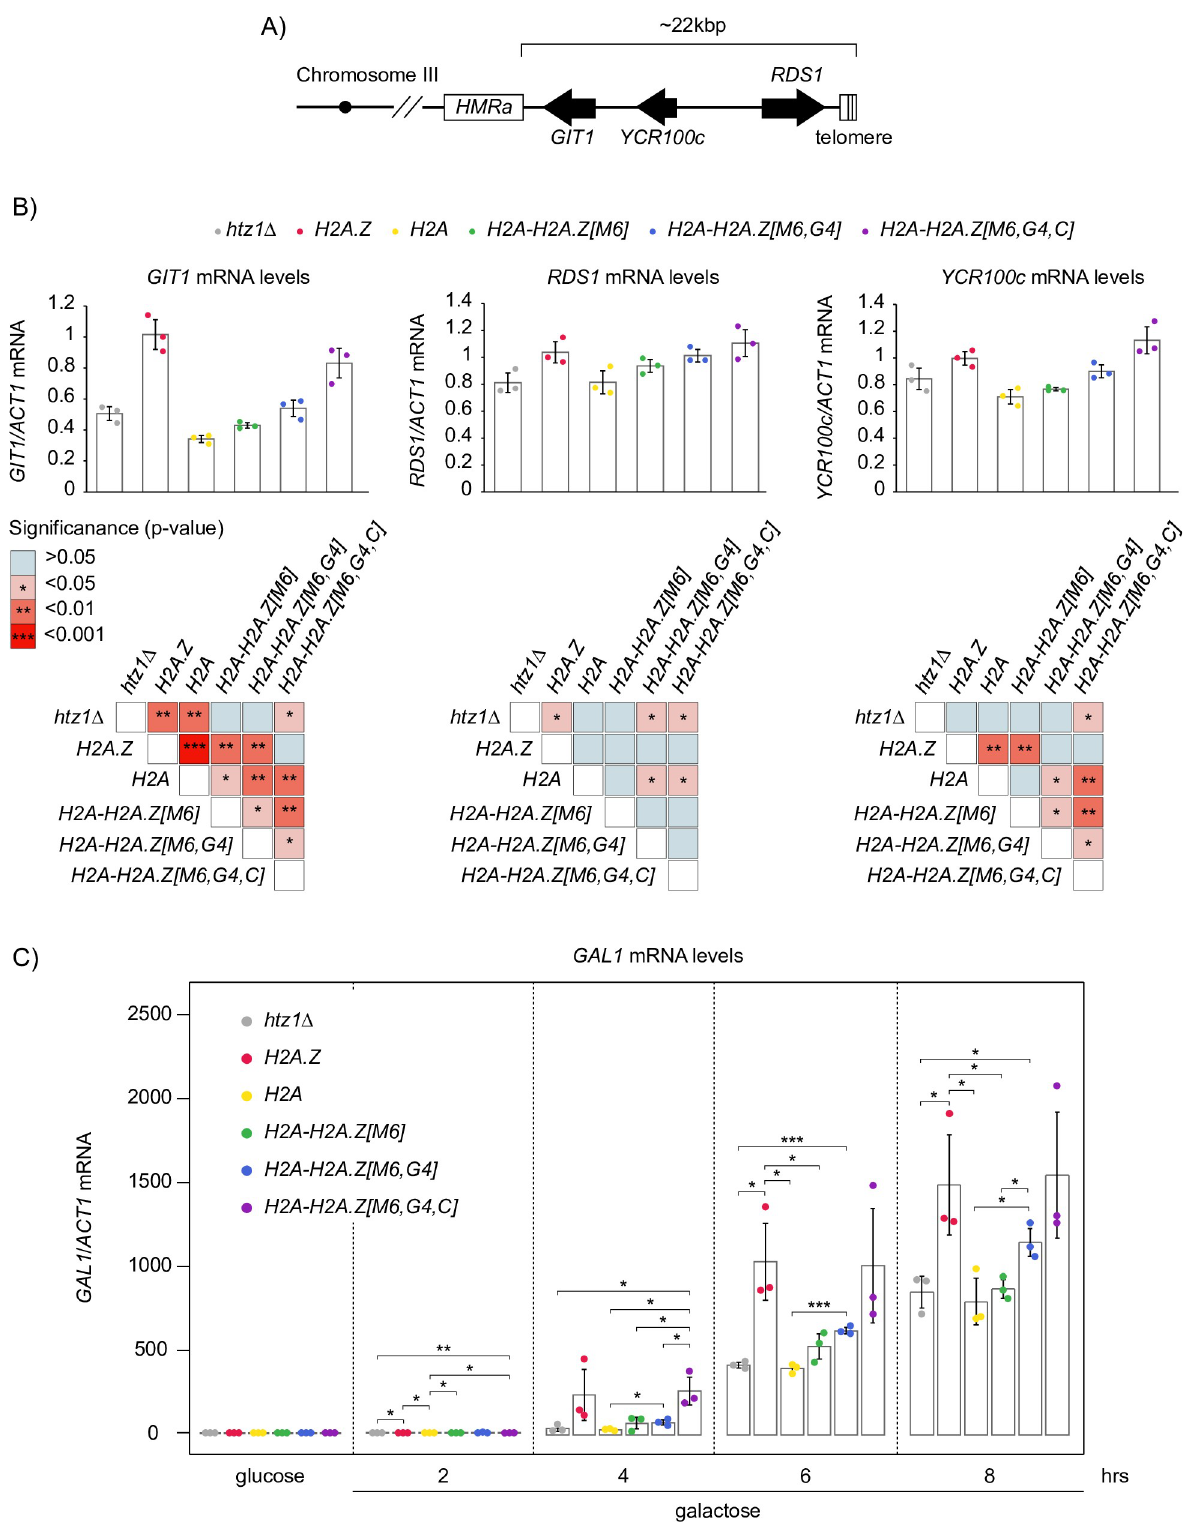
Fig 7. A combination of the three unique H2A.Z regions, M6, G4 and C-terminal tail, were sufficient to restore the mRNA levels of heterochromatin-proximal genes and GAL1 after derepression. (A) Schematic representation of H2A.Z-dependent genes at the boundaries of